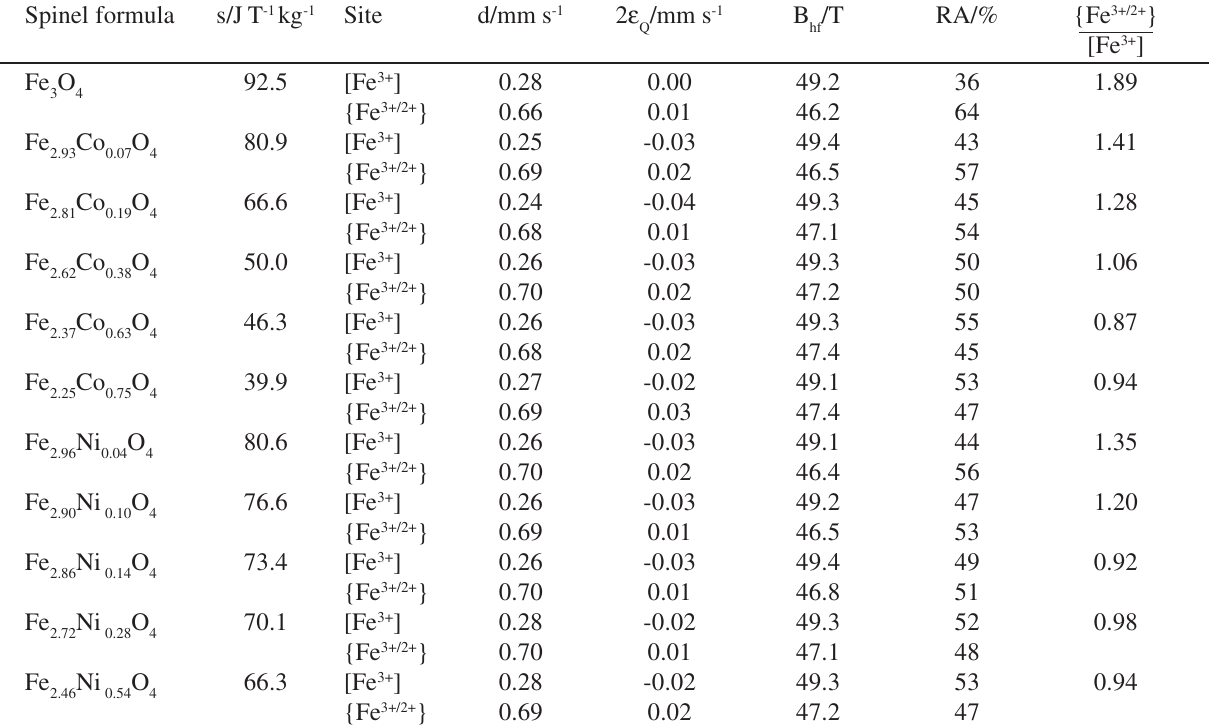
Table 1. Chemical formula, saturation magnetization and room-temperature Mössbauer parameters of samples. δ = isomer shift relative to α− Fe; 2 ε = quadrupole shift; B = hyperfine field; RA = relative spectral area, and [Fe 3+ ] and {Fe 3+/2+ } = tetrahedral and octahedral sites Q hf